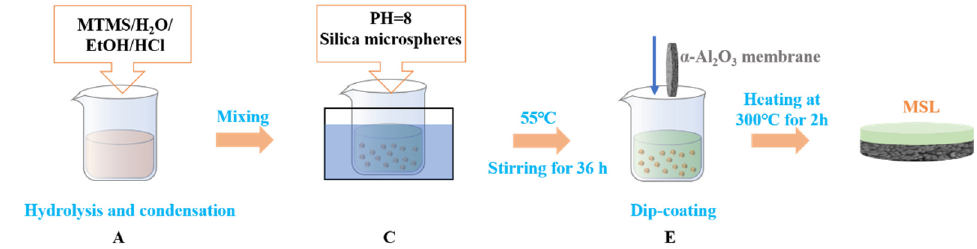
Figure 1. Fabrication process of the MSL ‐ supported α‐ Al 2 O 3 ceramic membranes.